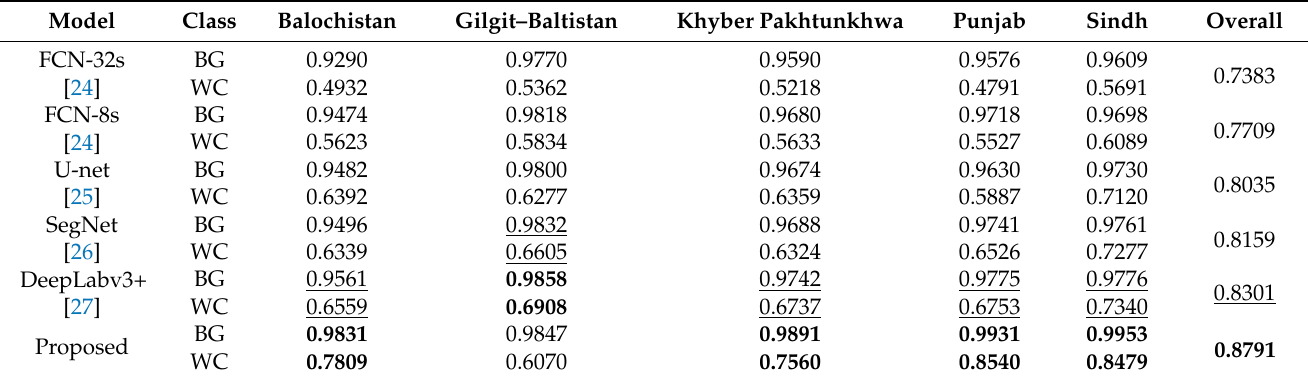
Table 4. Comparative evaluation of the proposed AUnet with other SOTA methods. Bold font shows the best results. The second-best performance is